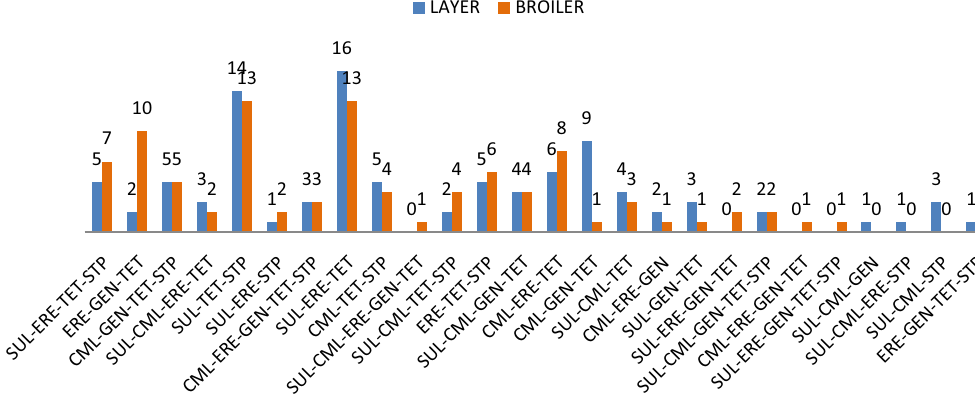
Figure 1. MDR profiles of E. coli isolates from broiler ( n = 97) and layer ( n = 94) chickens. SUL sulfonamide (a representative of folate pathway inhibitors), CML chloramphenicol (a representative of phenicols), ERE